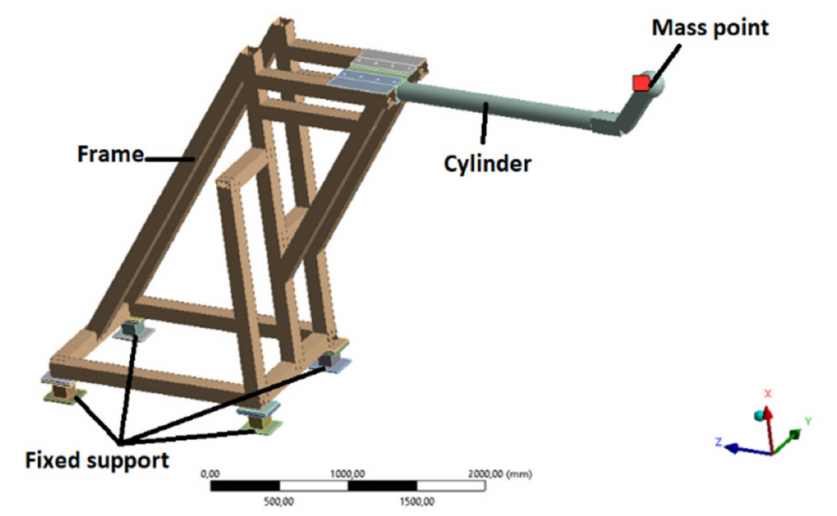
Figure 4. Complete geometry of Thomson scattering diagnostic